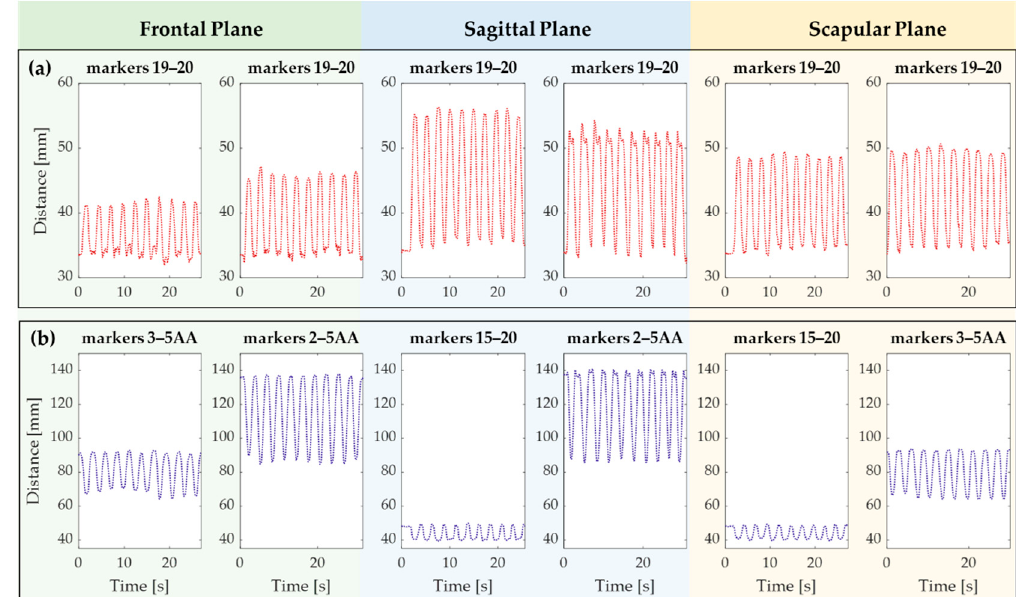
Figure 6. The distance trends recorded on a volunteer during the six tasks. ( a ) Example of pairs of markers showing skin extension and ( b ) skin compression during the elevation phase. Table 2. Descriptive statistics (mean, standard deviation, median, min, max of strain), results of the test for normality (Shapiro–Wilk), and test for difference between strain distribution at 90° and maximum elevation (Wilcoxon rank-sum test) performed in the frontal, sagittal, and scapular plane. Variable ¯